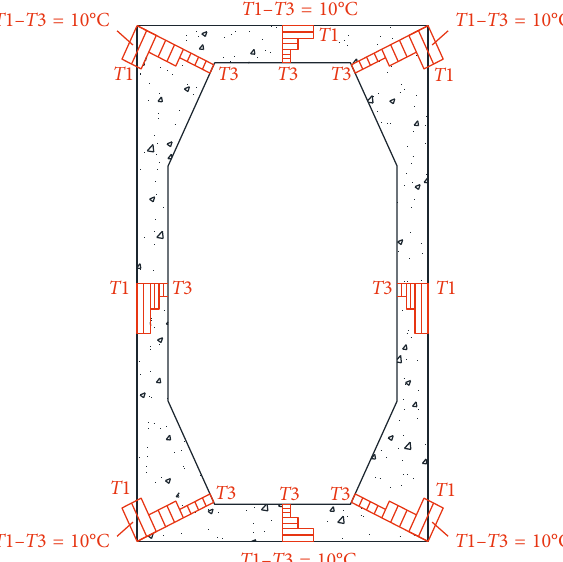
Figure 10: Temperature gradient distribution in the arch rib model.